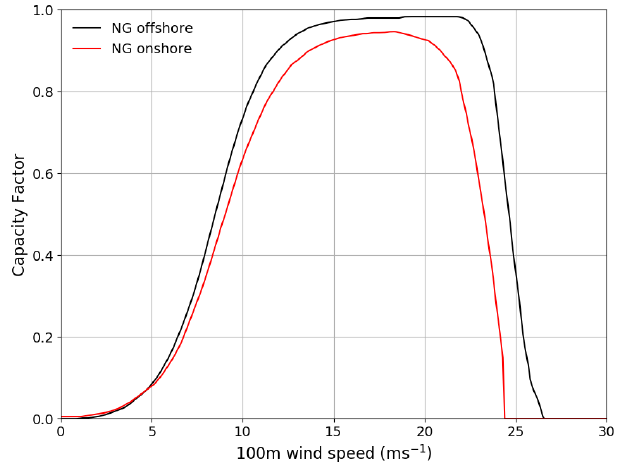
Figure 5. The onshore (red) and offshore (black) wind power curves used in this study, taken from National Grid